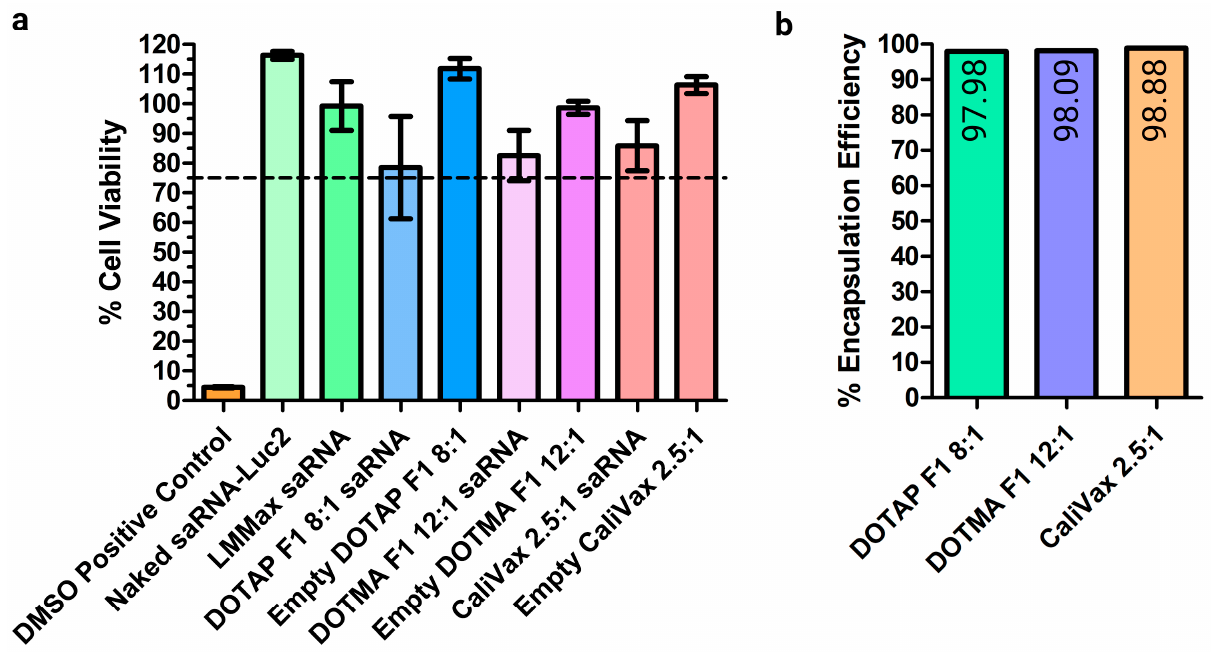
Figure 5. Absence of toxicity and high encapsulation efficiency of saRNA-Ext-cLNPs. ( a ) MTT cell toxicity assays were performed following transfection of saRNAs alone, cLNPs alone (empty) and formulated/complexed saRNA-cLNPs. Transfection of saRNAs with Lipofectamine Messenger Max (LMMax) and DMSO were included as controls. saRNA-cLNPs were found not to be toxic as percentage viability remained above 75%. ( b ) Encapsulation efficiency of CaliVax, and DOTMA and DOTAP F1 saRNA-cLNPs was >95% as measured by RiboGreen assay, showing strong adsorption of saRNA to the surface of the cLNPs. Results are depicted as the mean, with standard error of the mean. Created using GraphPad prism 4 and 5 and BioRender.com.